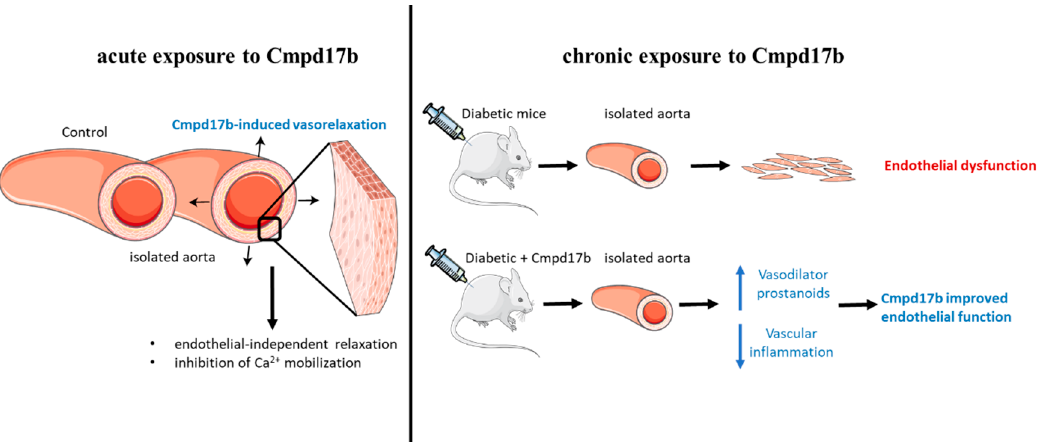
Figure 8. Summary of the impact of FPR agonist Cmpd17b on acute and chronic exposure in isolated mouse aorta. Cmpd17b induced endothelial independent relaxation acutely, and improved endothelial function in diabetic aorta chronically.